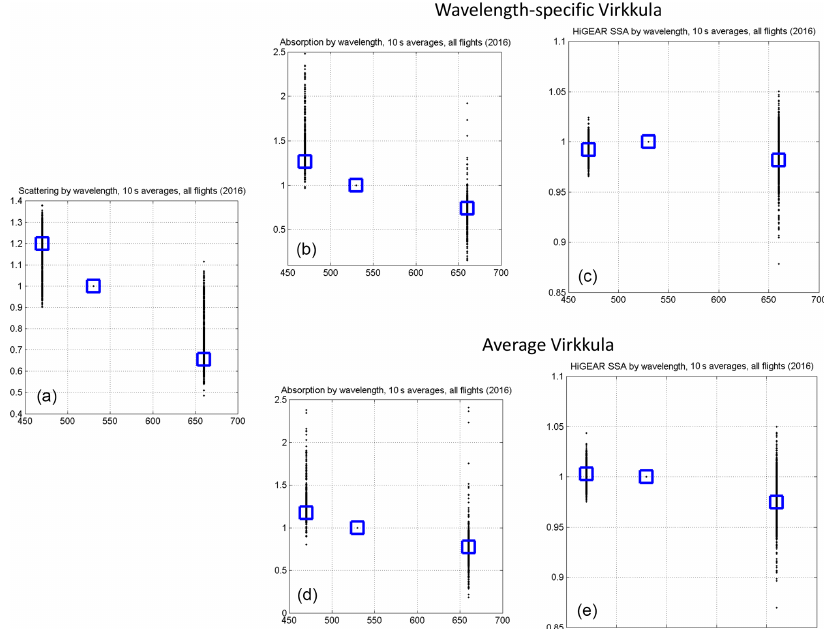
Figure A1. Normalized nephelometer scattering (a) , PSAP absorption (b, d) , and resulting SSA (c, e) for 470, 530, and 660nm, using wavelength-specific (b, c) and wavelength-averaged (d, e) Virkkula corrections. Values are normalized to highlight the relative spectral shape. Blue squares indicated the median of all observations (black). Note that while the scattering and absorption both exhibit an overall decrease with wavelength, the much sharper decrease in absorption results in a small maximum in SSA at 530nm under the standard wavelength-dependent Virkkula corrections applied to the PSAP. This spectral feature disappears in the average Virkkula case.